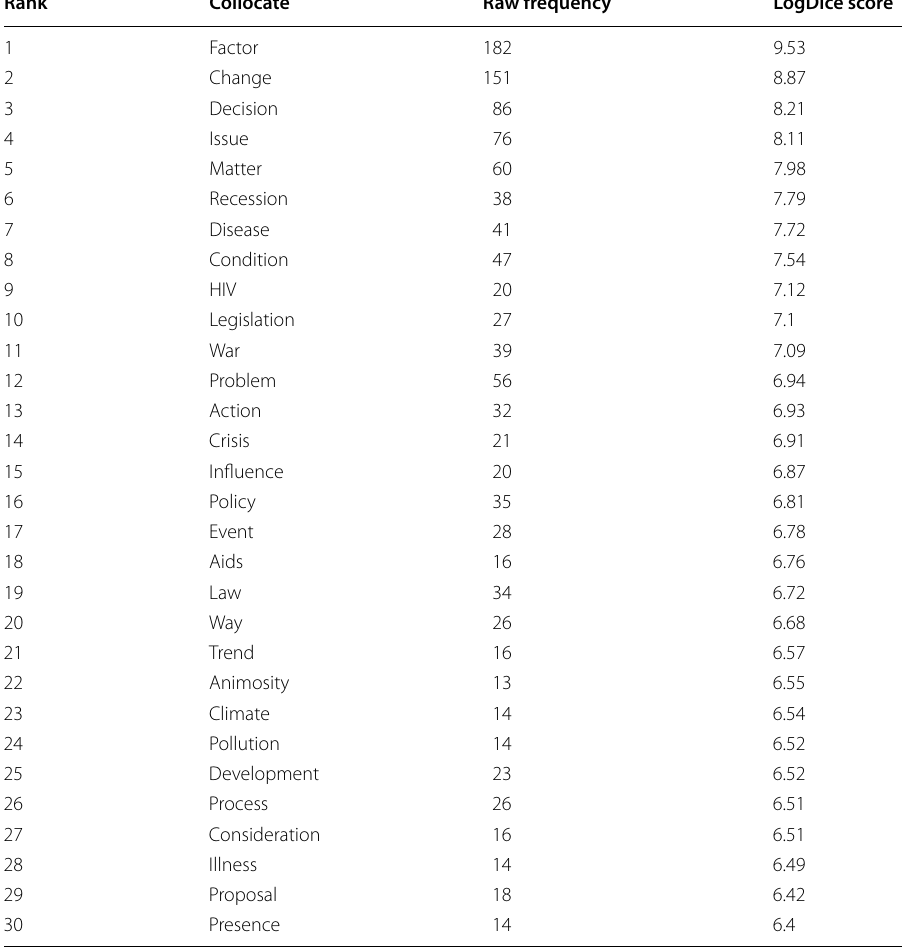
Table 7 Nominal subject collocates of affect